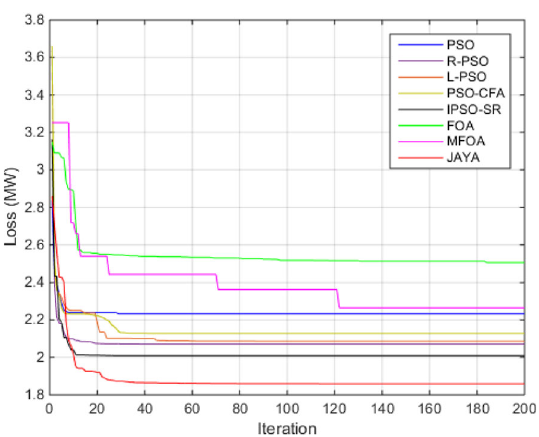
Fig. 9 Convergence characteristics of the algorithms for the IEEE 30 bus system with DG injection